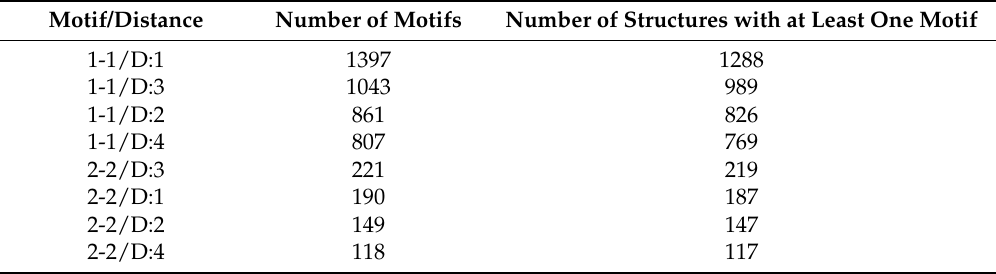
Table 4. Motif occurrence in the S4 set. The number of motifs was calculated based on the number of specific patterns in defined locations, referring to structures which contain at least one